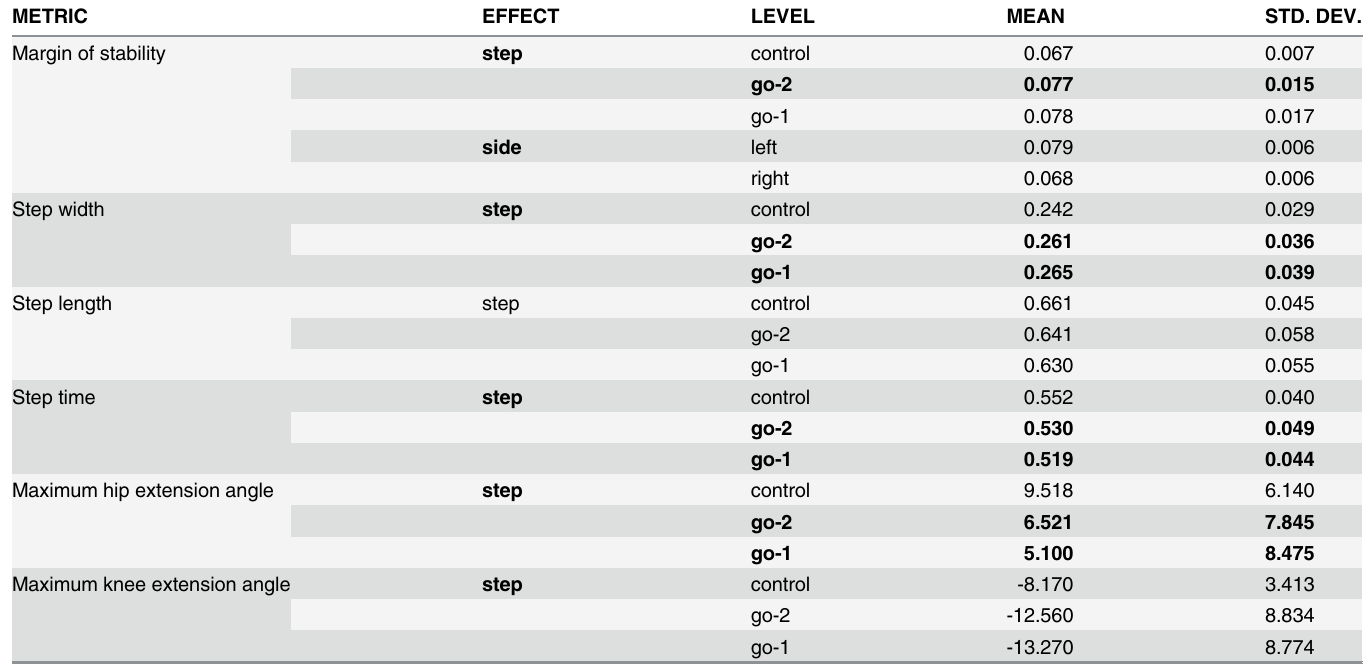
Table 3. Means and standard deviations for Unknown condition.